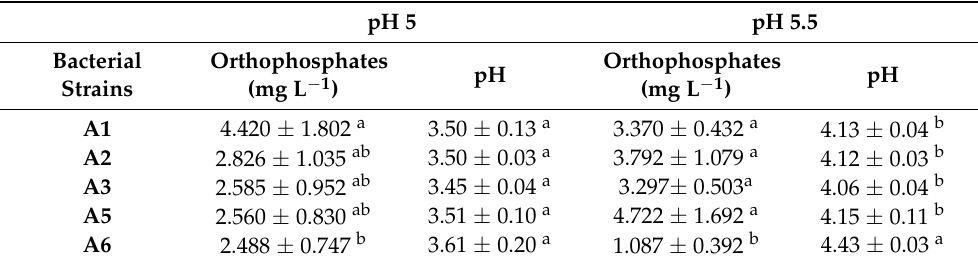
Table 1. Phosphate solubilization by PSB in acidic pH regions after 8 days of incubation.